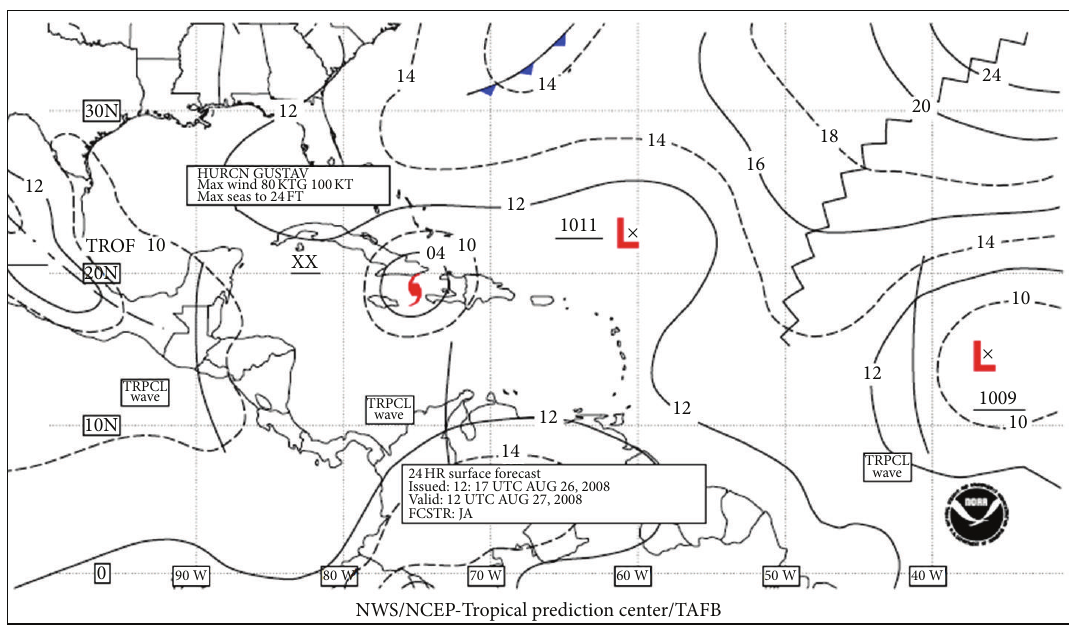
Figure 1: Surface forecast of the Caribbean region valid at 1200UTC 27 August